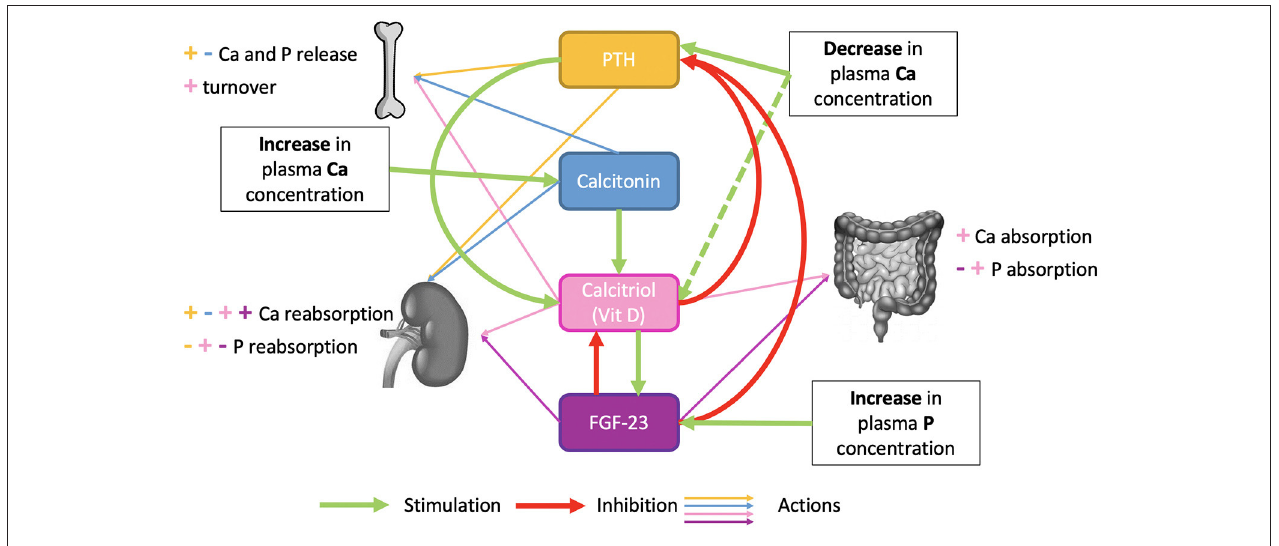
FIGURE 7 | Hormonal regulation of phosphocalcic